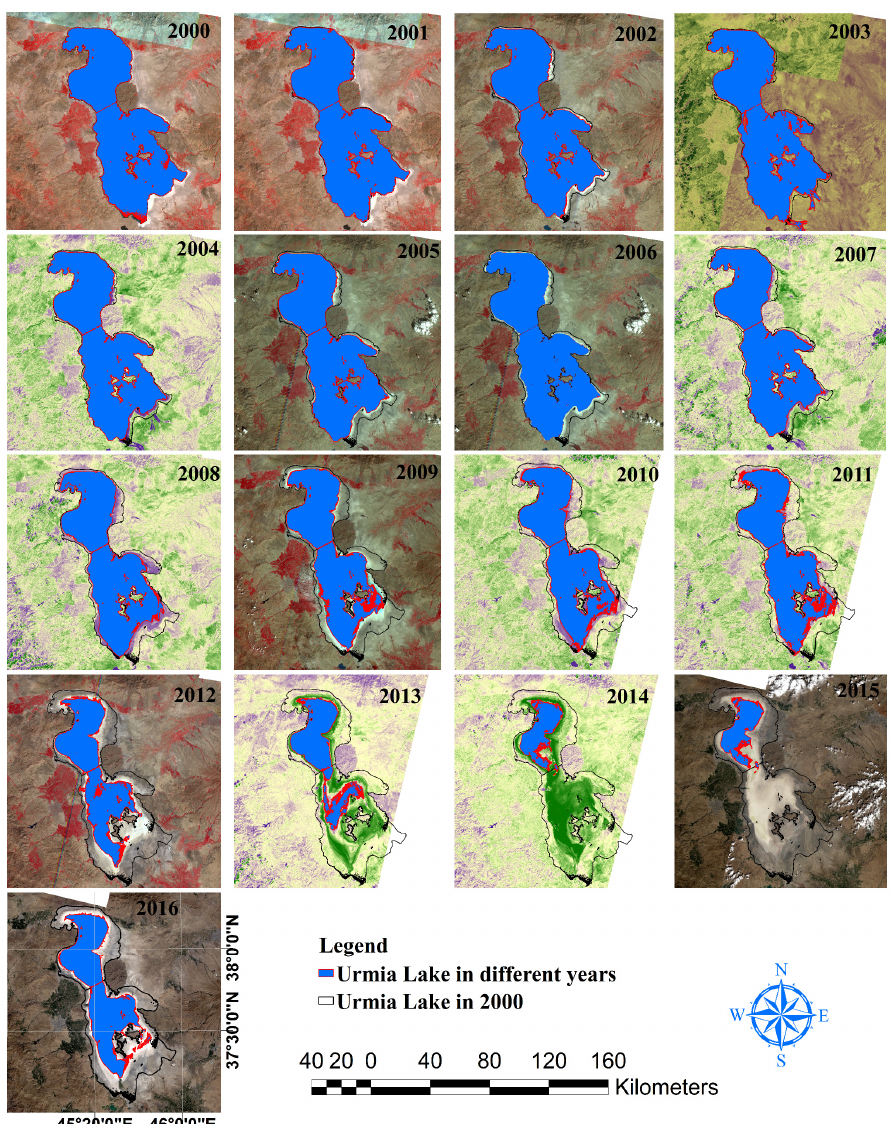
Figure 6. Maps illustrating surface area changes in LU as extracted from Landsat satellite images.